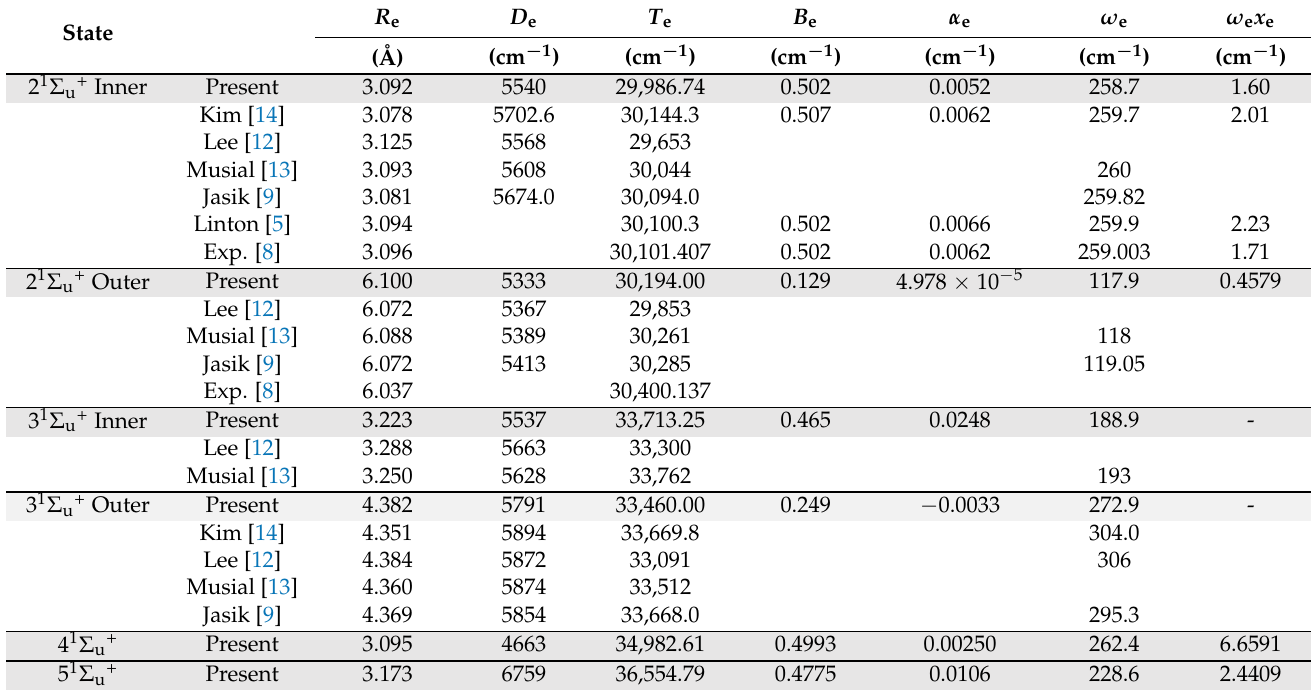
Table 3. Spectroscopic constants of 2, 3, 4 and 5 1 Σ u+ states of 7 Li 2 .